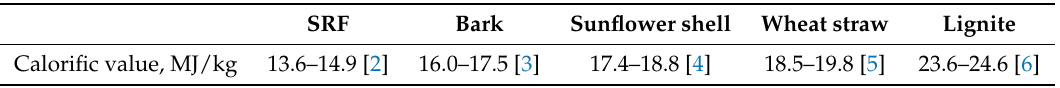
Table 1. Comparison of the calorific values of renewable fuels and lignite. SRF Bark Sunflower shell Wheat straw Lignite Calorific value,